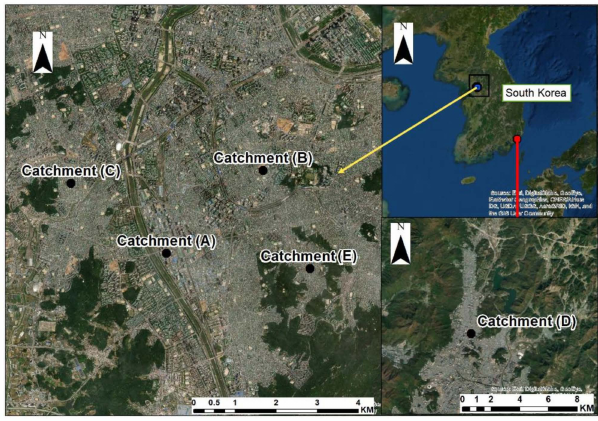
Figure 7. Site location of validation